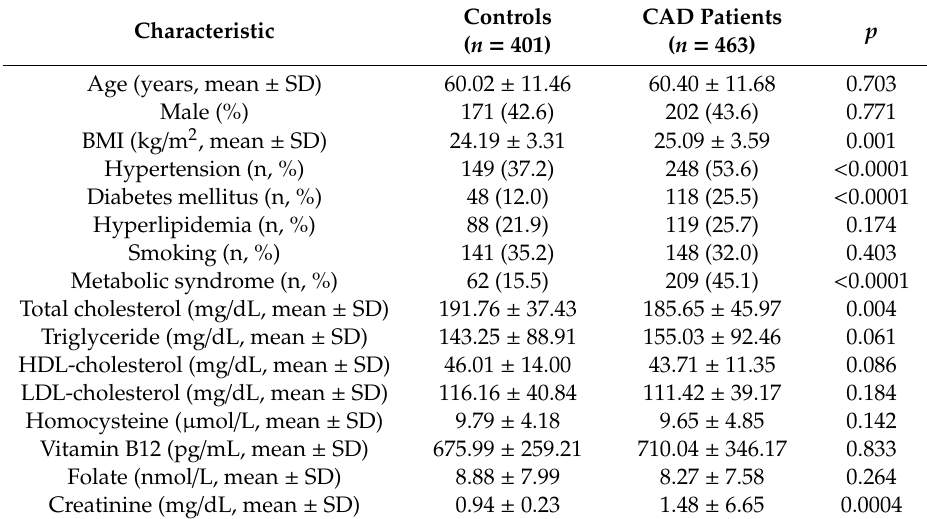
Table 1. Baseline characteristics between CAD and